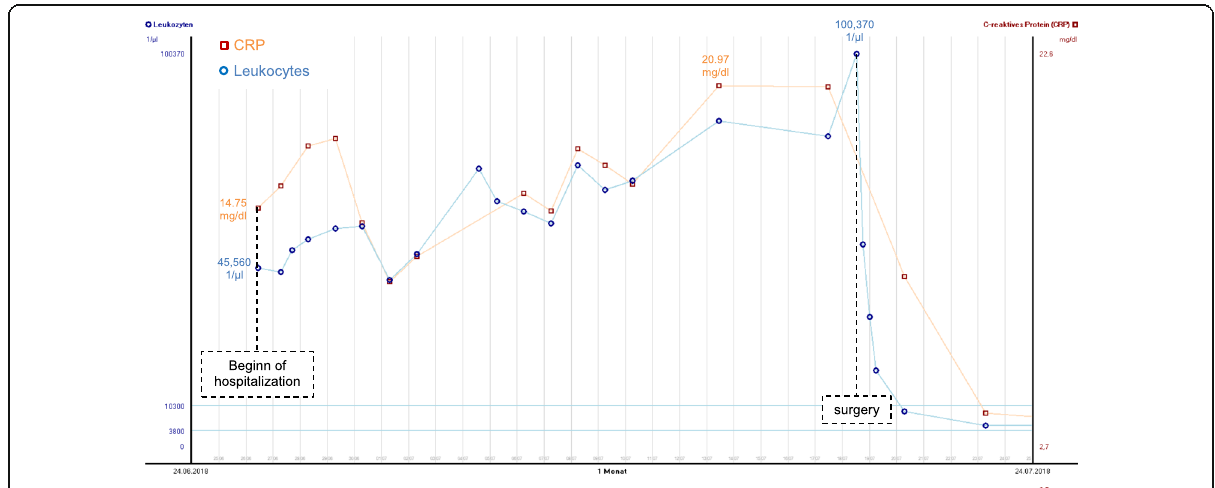
Fig. 3 The inpatient admission of the patient was at a CRP of 14.75 mg/dl and increased leukocytes (45,560/ μ l). The CRP increased to a maximum of 20.97mg/dl preoperatively, and the leukocytes reached their peak on the day of surgery with a value of 100,370/ μ l. Immediately postoperative both inflammatory values dropped sharply and leucocytes reached their normal values on the third postoperative day (8770/ μ l) and CRP on